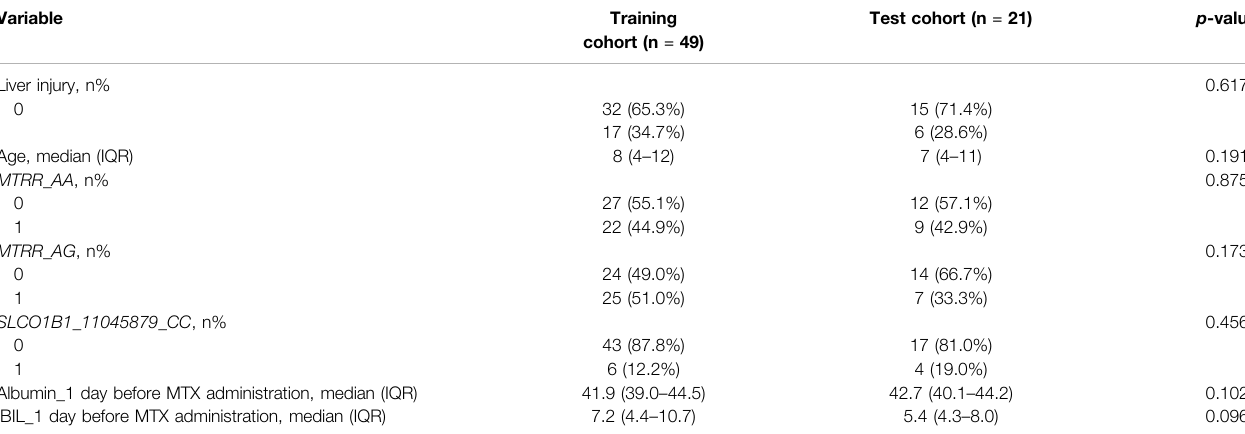
TABLE 4 | Comparison of signi fi cant variable characteristics between training and test